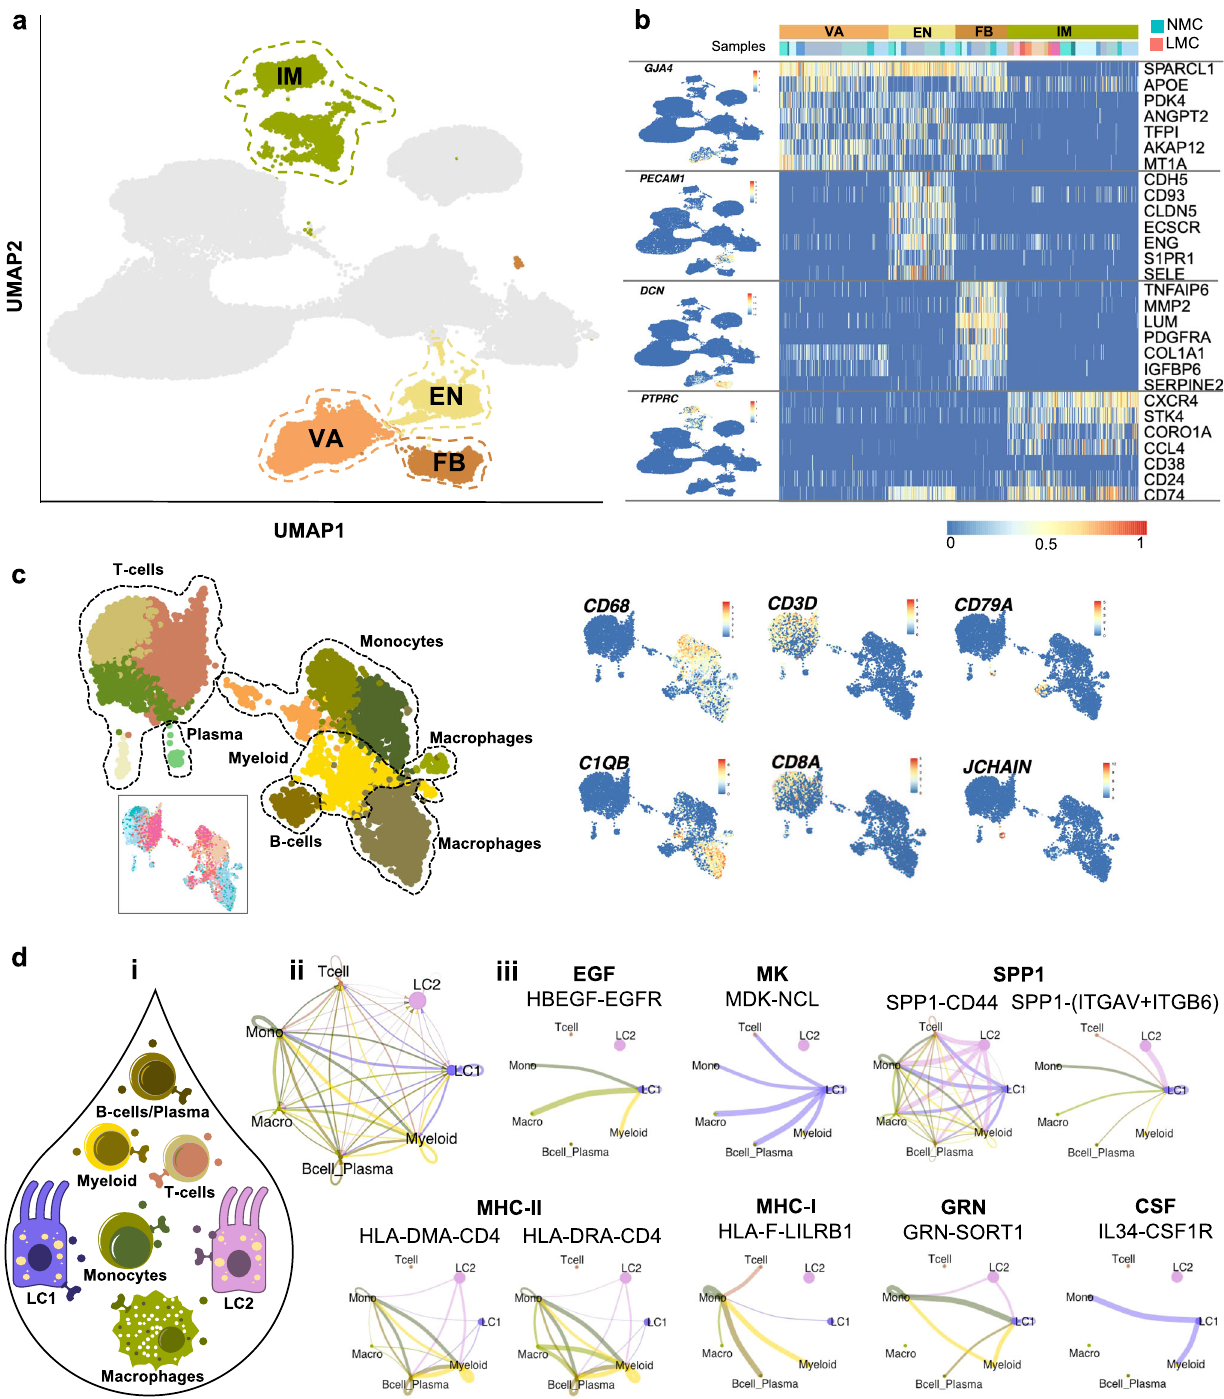
Fig. 3 Investigation of the stromal compartment of non-lactating and lactating mammary epithelial cells. a Stromal cells were classi fi ed into vascular accessory (VA), endothelial (EN), fi broblasts (FB) and immune (IM) cells. b Canonical stromal markers were used to classify the different stromal subtypes where LMC only contained IM cells. c Sub-setting and re-clustering of IM cells revealed that both myeloid and lymphocytic lineages were sequenced from both NMC and LMCs. d CellChat analysis between luminal and immune cell subtypes identi fi ed in milk ( i ). ii Observed interactions between the cell types. iii All immune cell subtypes signal to LC1 via the EGF, MK and SPP1 signalling pathway (selected receptor – ligand pairs shown), whereas LC1 and LC2 luminal clusters from milk are signalling to milk immune cells via MHC-II, MHC-I, CSF and GRN signalling pathways (selected receptor – ligand pairs